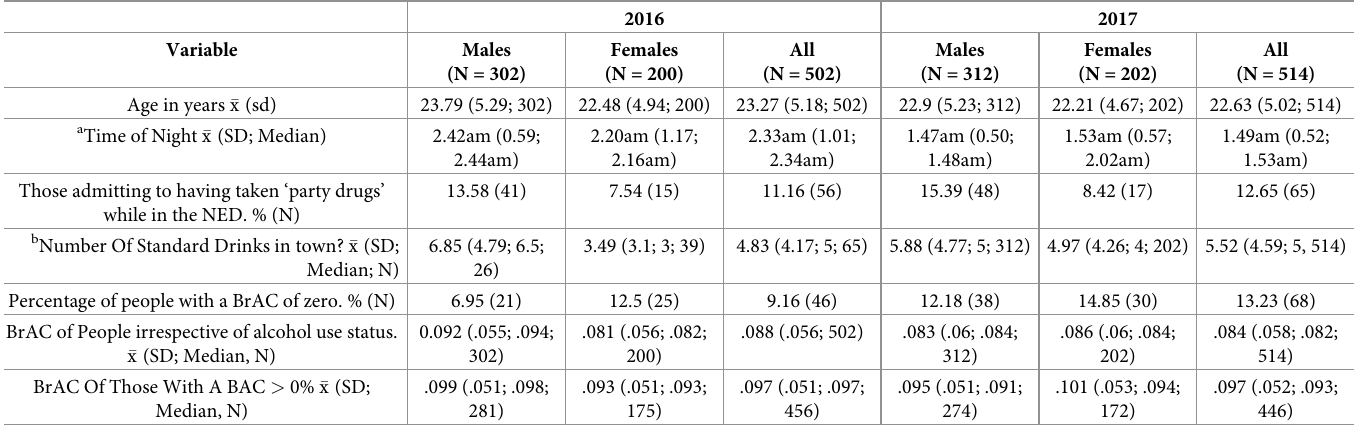
Table 7. January & February exit data for2016 & 2017.